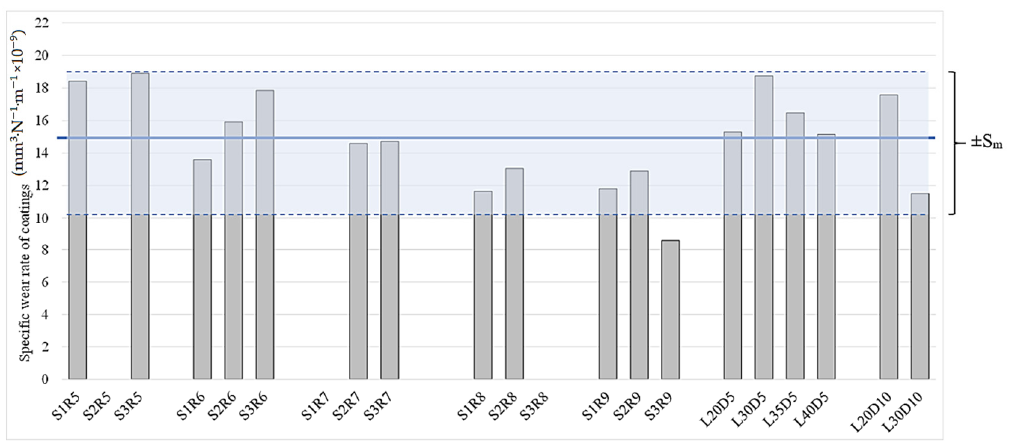
Figure 12. Specific wear rate from various ball-on-disc tests conducted under different conditions according to Table 3.